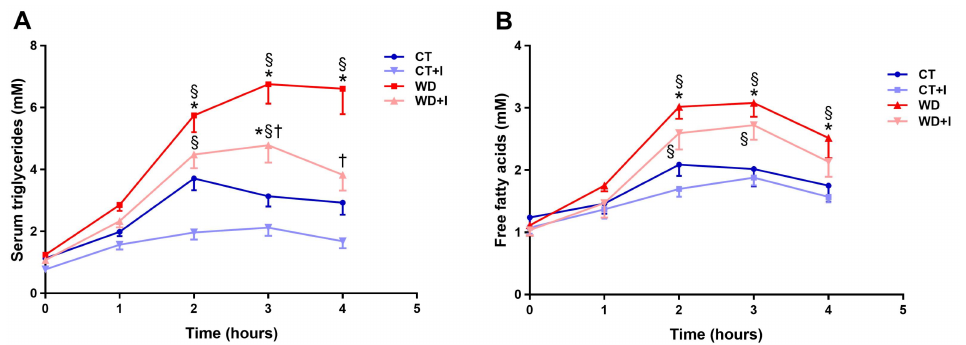
Figure 2. Serum triglyceride profile after olive oil load ( A ). Free fatty acid profile after olive oil load ( B ). Data are presented as mean ± SEM and analyzed with a mixed model ANOVA followed by Tukey post hoc tests. * p < 0.05 versus CT, § p < 0.05 versus CT + I, † p < 0.05 versus